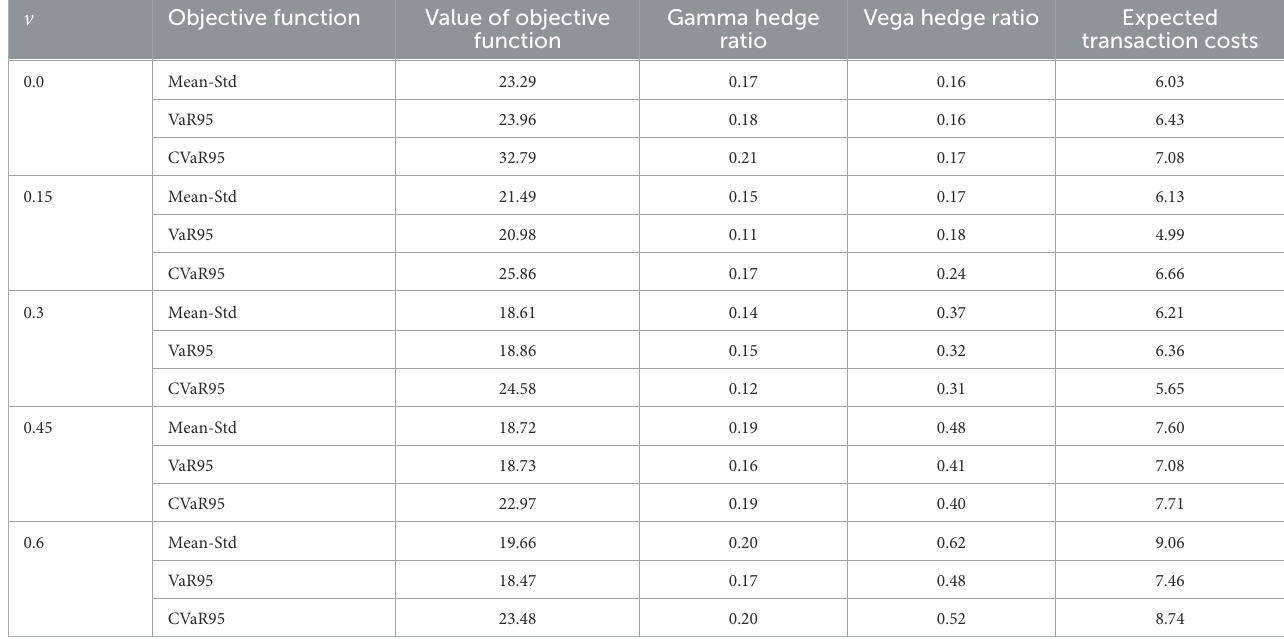
TABLE 4 Values of the objective function and expected cost of hedging when the hedging strategy is developed with values of the volatility of volatility, v , that are different from the actual 0.3 value. v